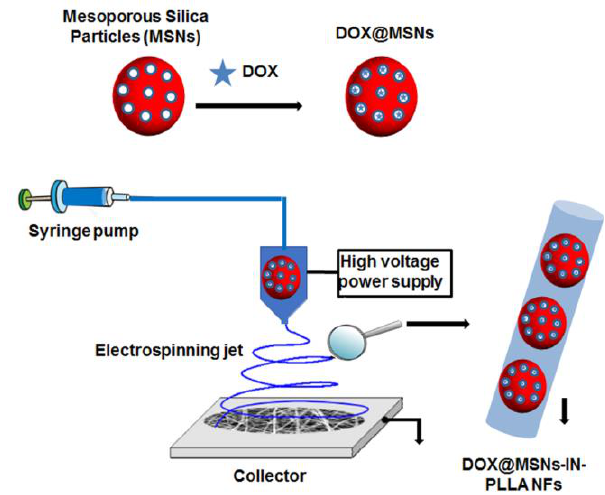
Figure 3. Schematic illustration for the process of fabrication of DOX@MSNs-IN-NFs electrospun composite NFs and the location of DOX in the fiber [40].